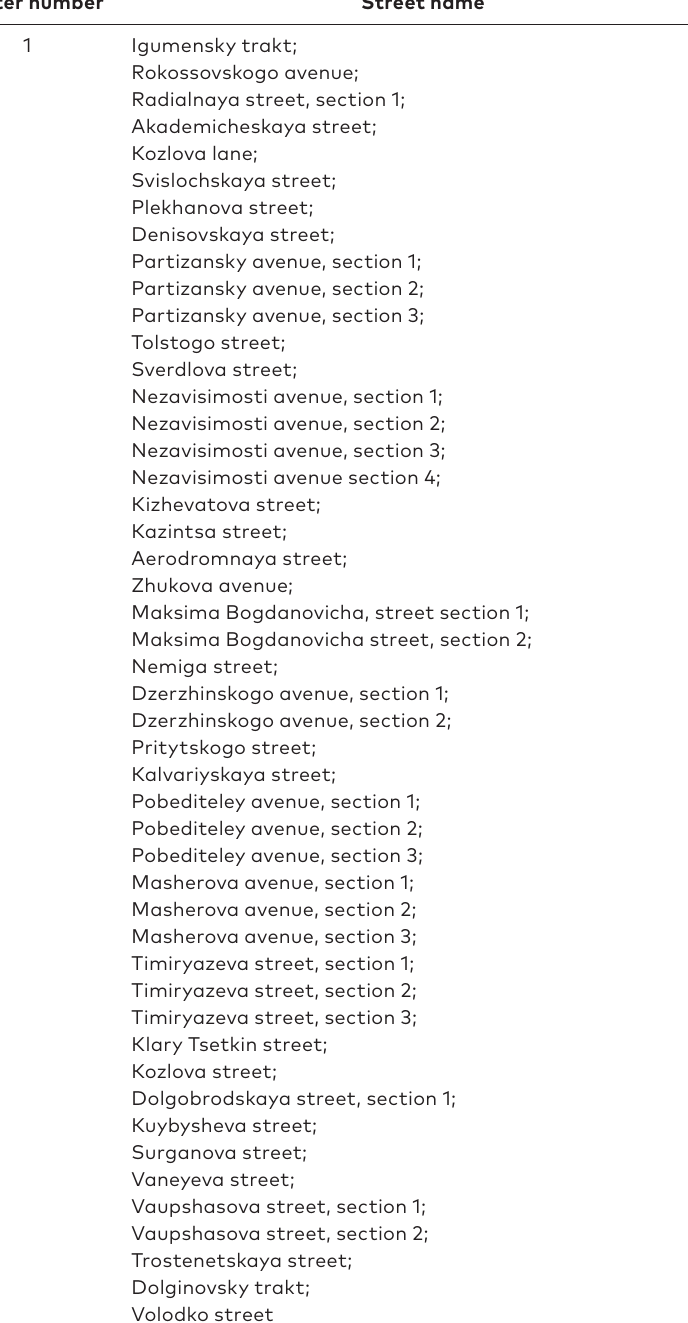
Table 2. The distribution of the streets of Minsk by